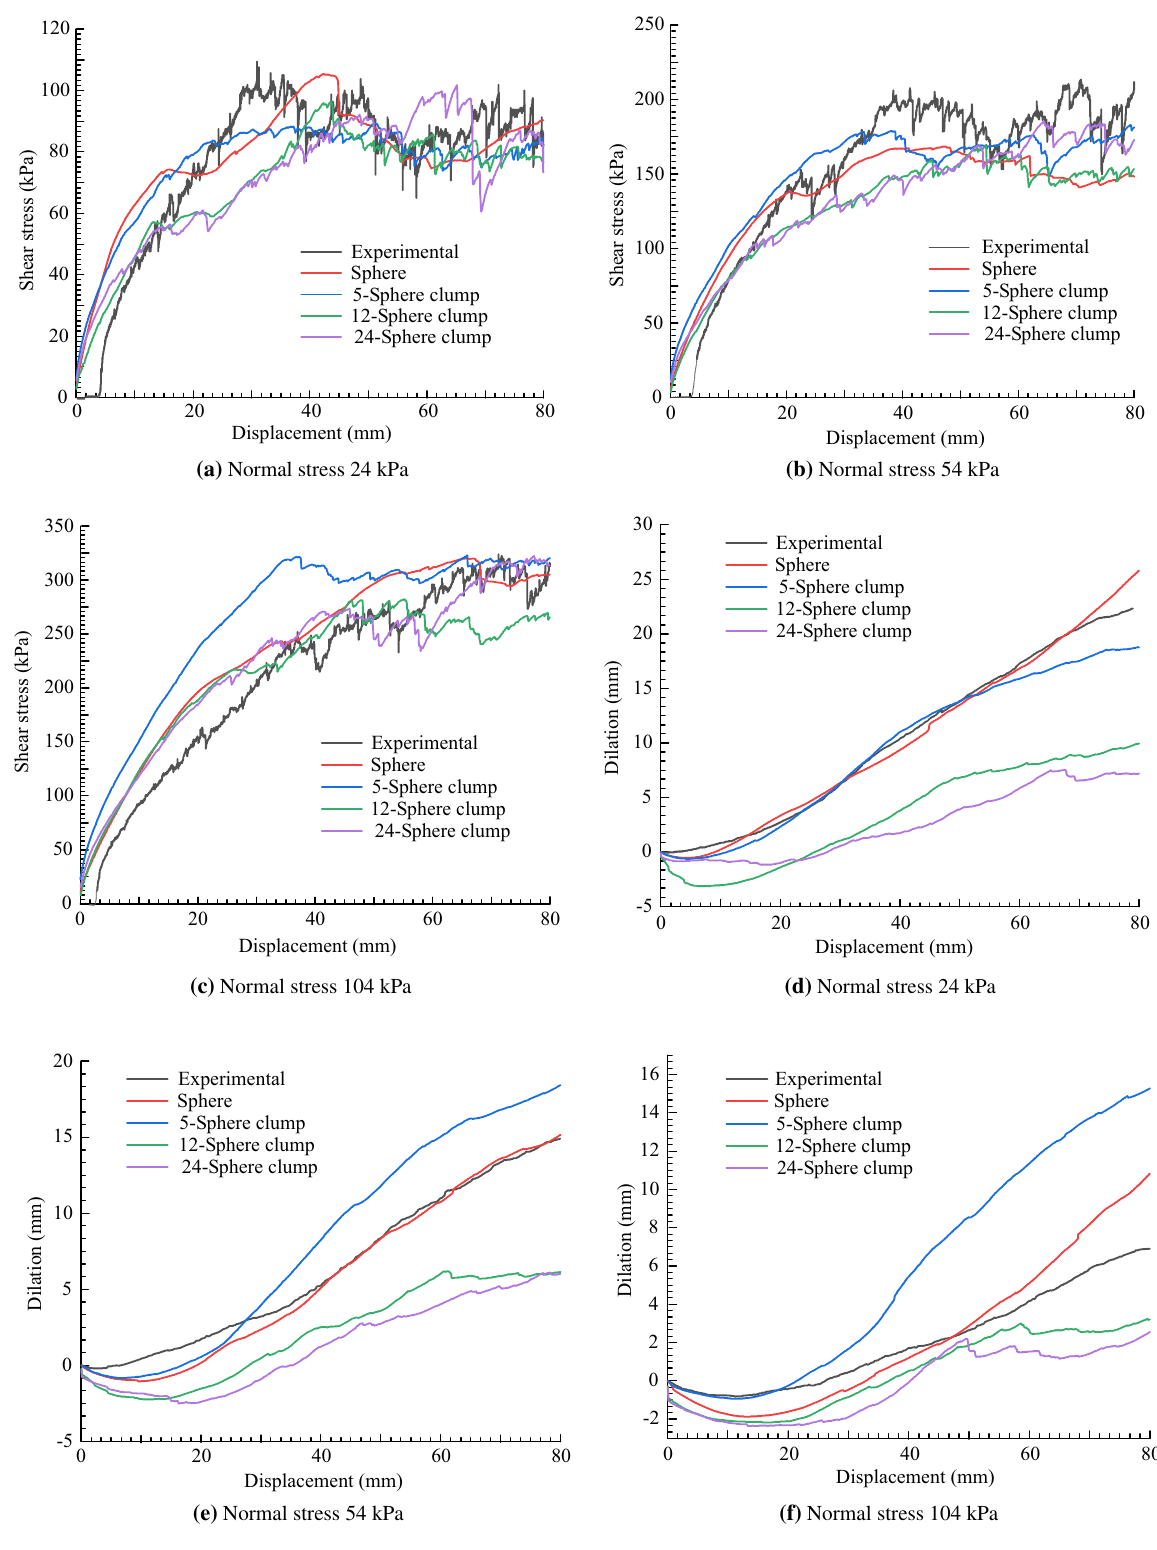
Fig. 6 Shear stress and dilation results of the DST simulation with different